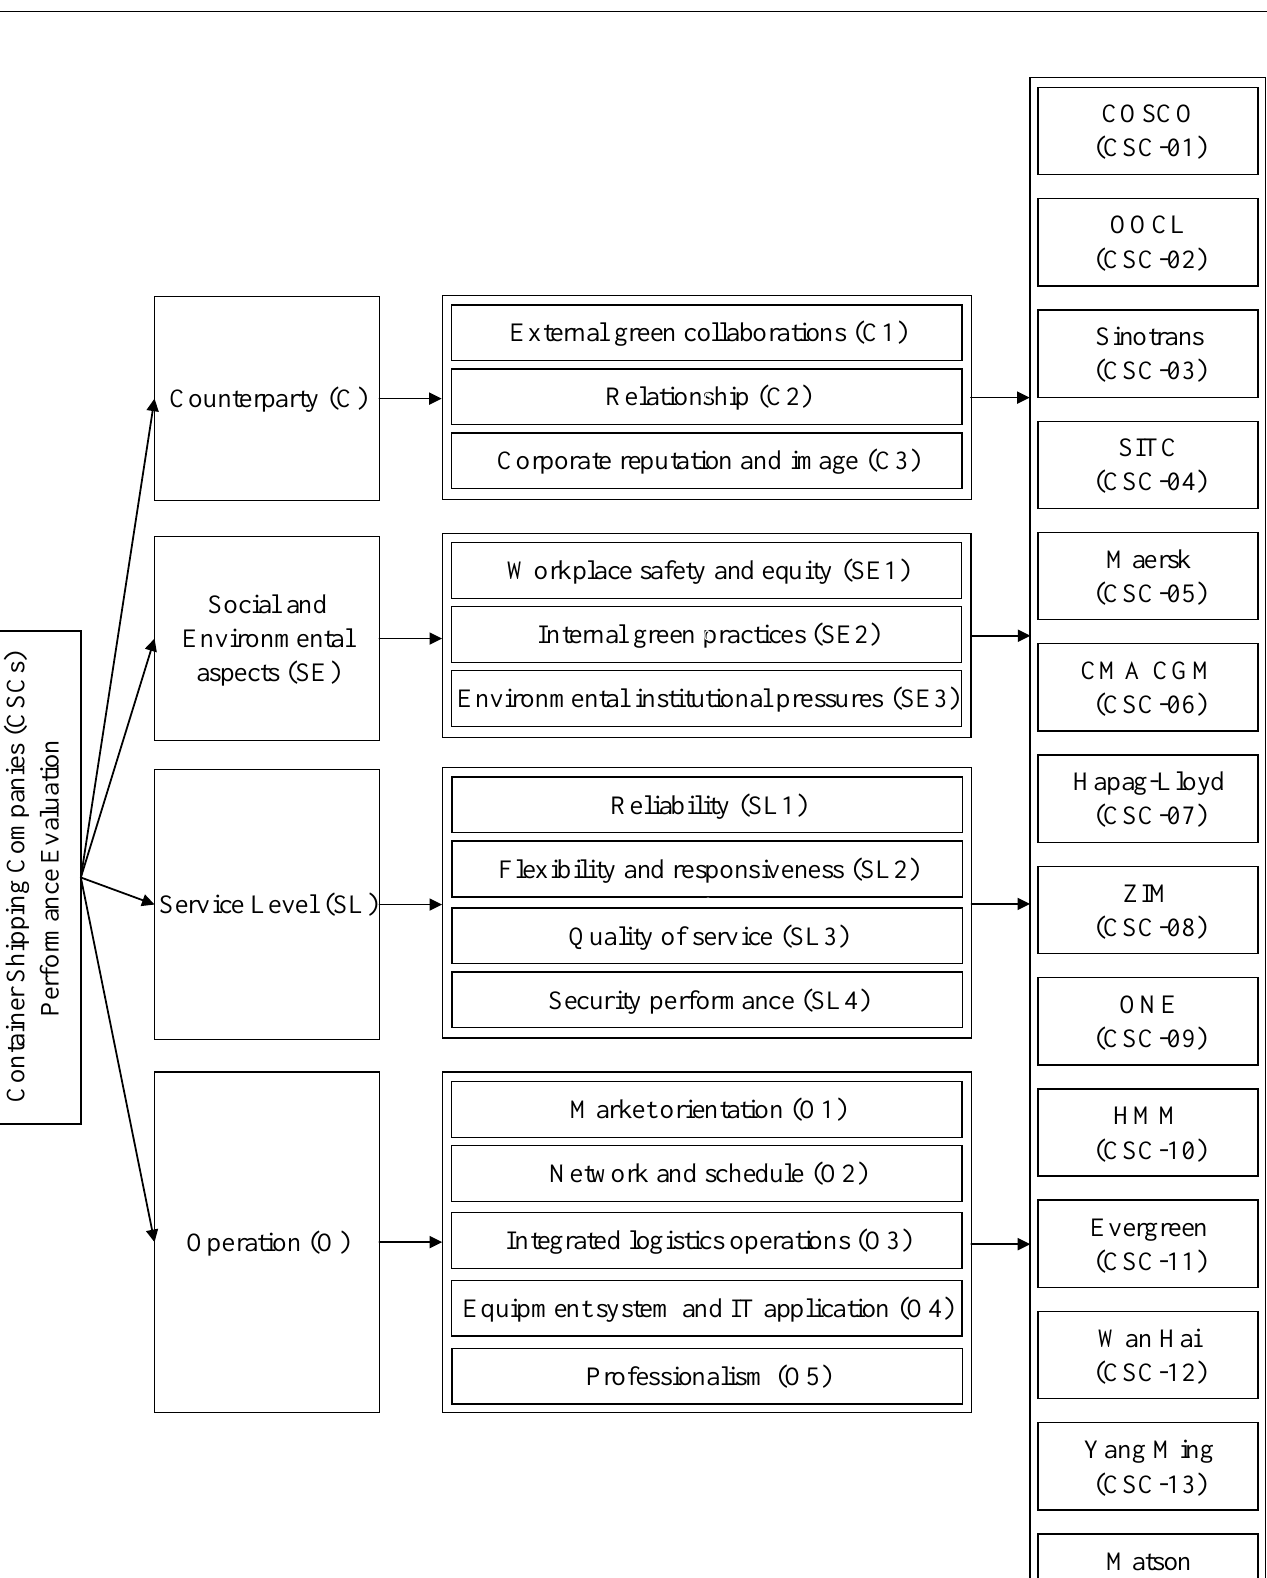
Figure 4. Hierarchical structure for qualitative performance analysis.